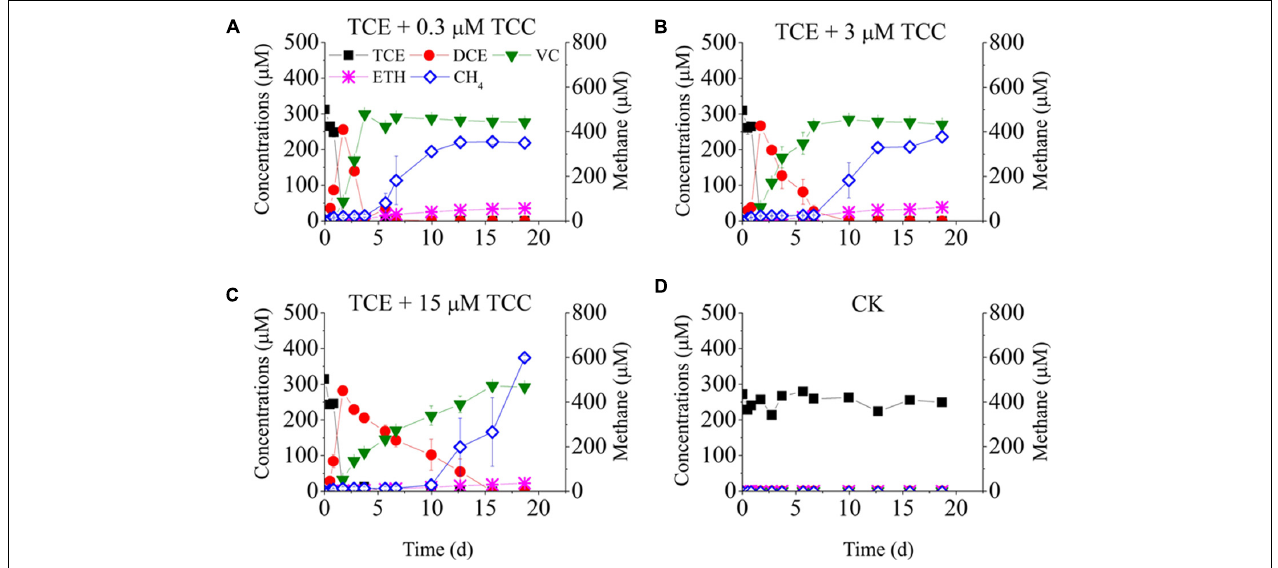
FIGURE 2 | Batch tests on the dechlorination of chlorinated ethenes in the cultures amended with different concentrations of TCC. Left Y -axis is the concentrations of chlorinated ethenes and ethene. Batch test (A) TCE + 0.3 µ M TCC; (B) TCE + 3 µ M TCC; (C) TCE + 15 µ M TCC; (D) Negative Control.